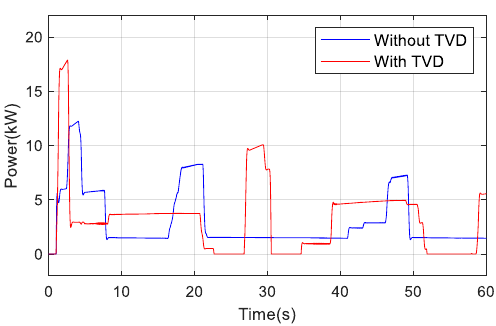
Figure 13. Curves of power.